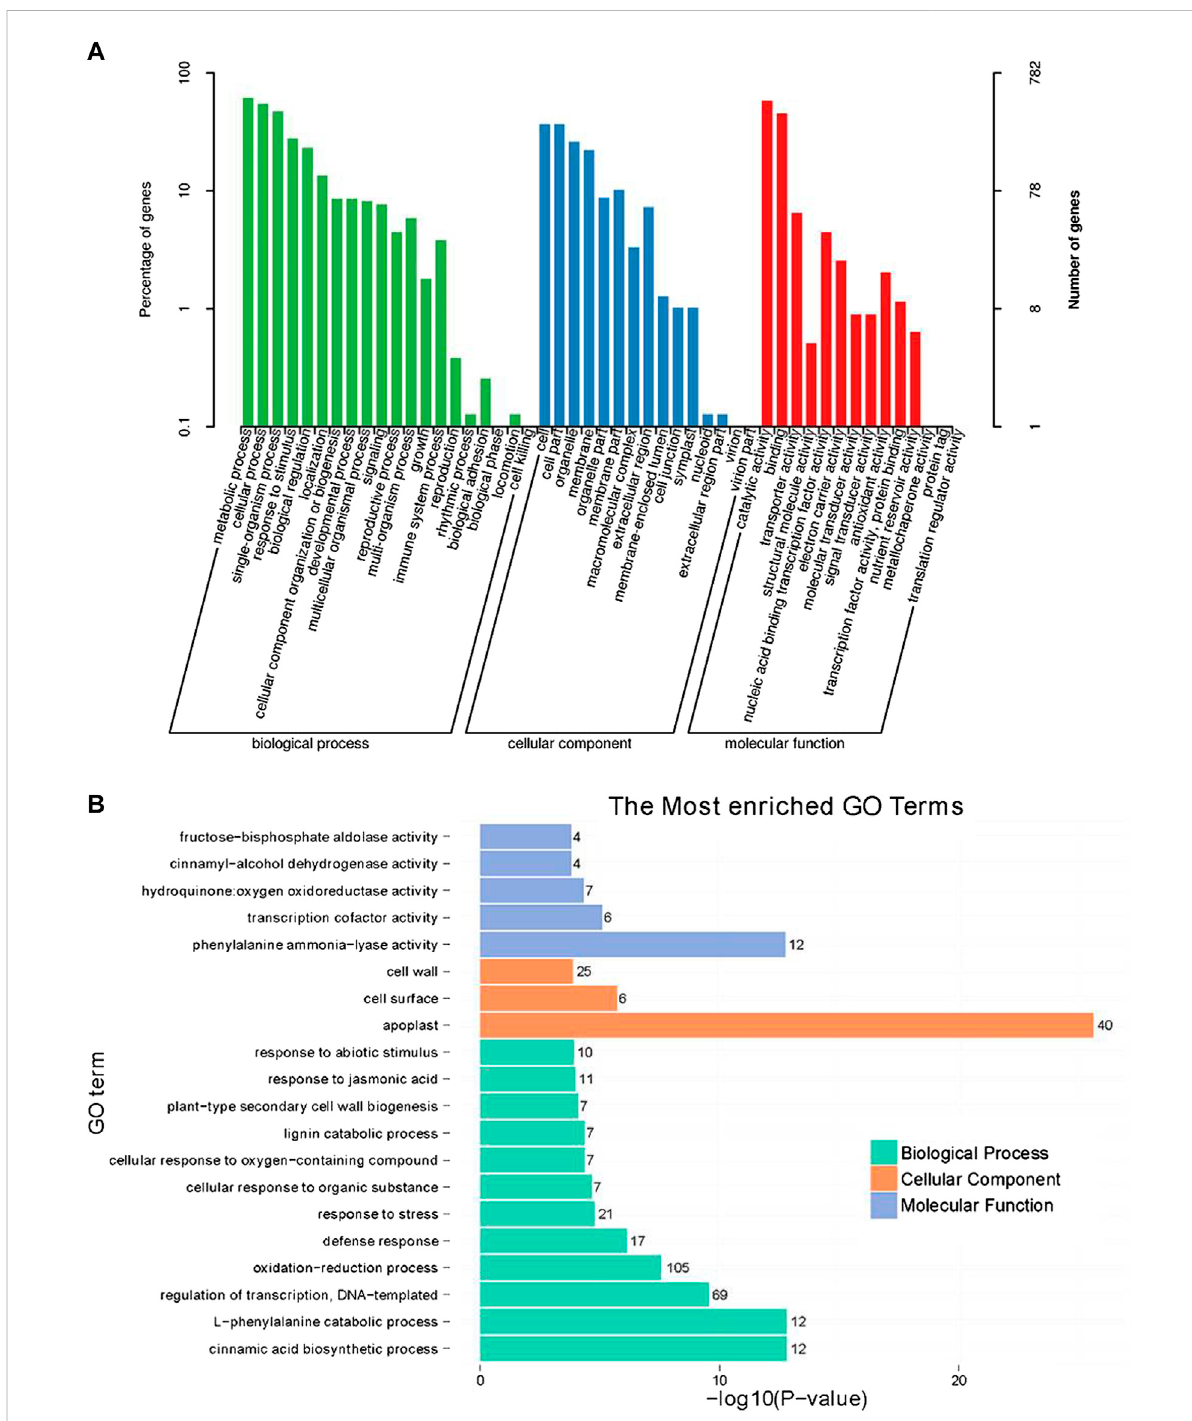
FIGURE 3 Gene ontology (GO) analysis of differentially expressed genes (DEGs) between shoot apical meristems of control and silver thiosulfate-treated plants. (A) GO functional categories. (B) Enrichment analysis of DEGs based on molecular function, cellular component, and biological process categories. The fi gures on the left of each term represent the number of